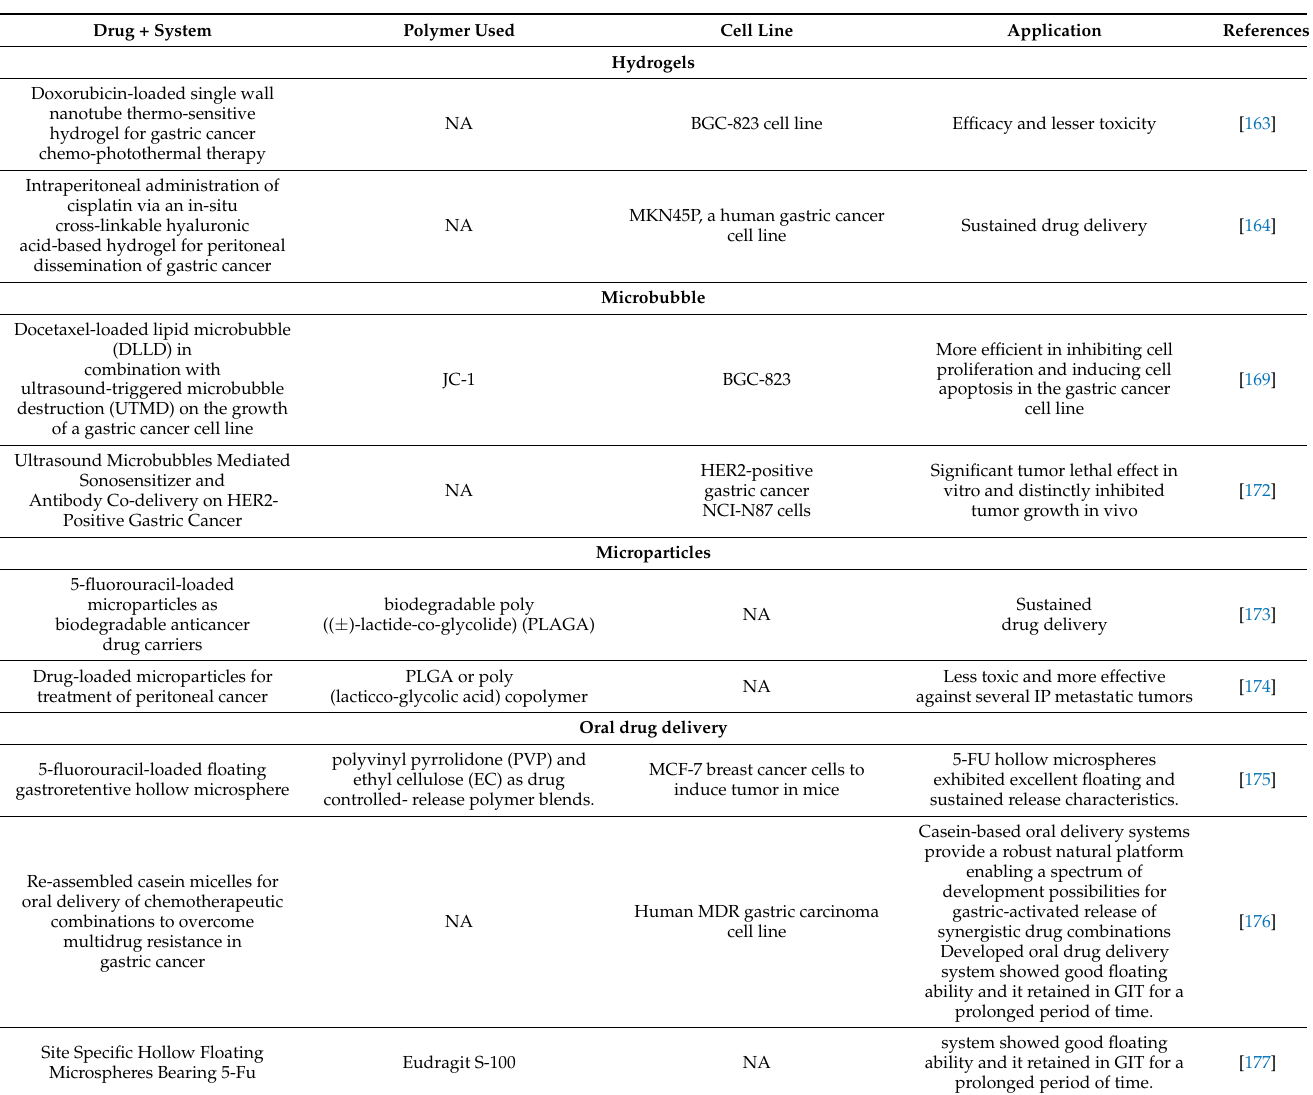
Table 3. List of anticancer drugs, polymers, and cell lines used in drug-delivery systems for the treatment of stomach cancer with their